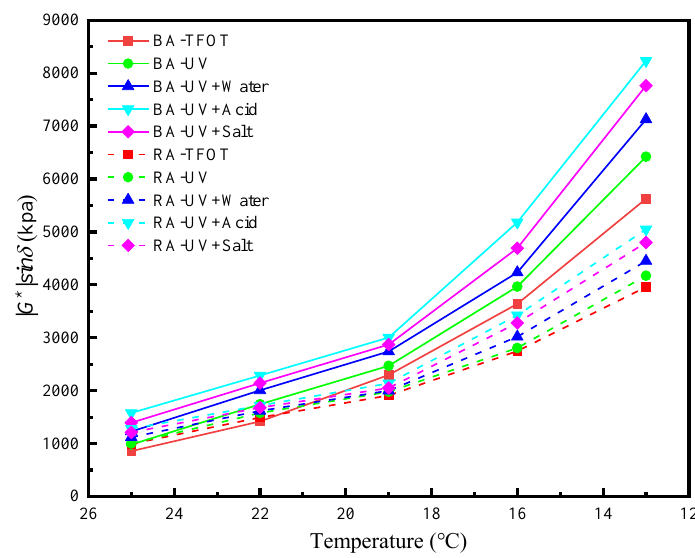
ff erent environmental